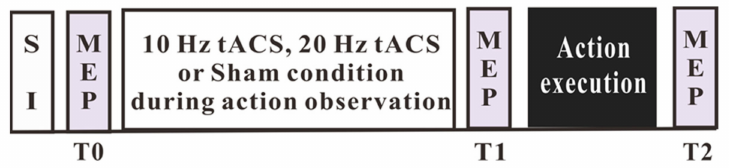
Figure 1. Timeline of the experimental design. Either tACS at 10 Hz and 20 Hz or a sham stimulation was applied over the left M1 during the action observation, followed by the action execution. Twenty motor-evoked potentials (MEPs) per time point (before, and after the action observation, and after the action execution) were obtained via a single-pulse TMS with an intensity that elicited MEP amplitudes of about 1 mV (SI1mV) at